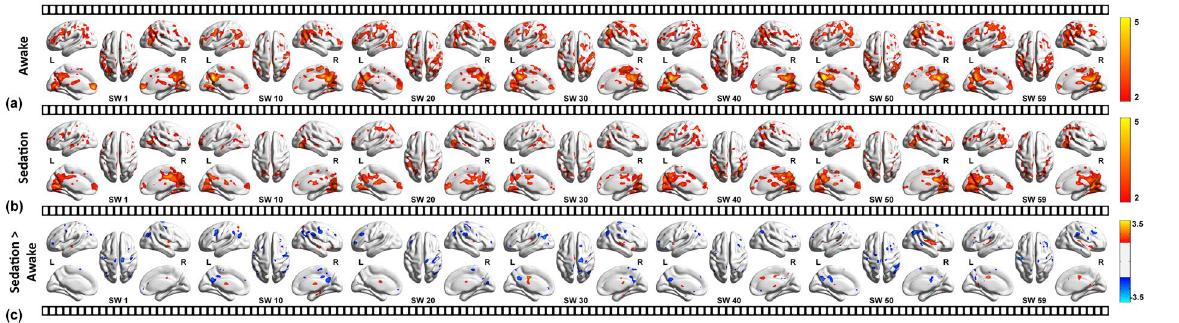
Figure 1. Dynamic functional connectivity during the awake state, sedation and the differences between two conditions is depicted in rows. Seven representative snap shots of integrated local correlation at sliding window 1, 10, 20, 30, 40, 50 and 59 is shown overlapped on BrainNet viewer images. Decreased cortical connectivity is represented in blue and increased deep nuclear connectivity is depicted in red in the last row which represents the effects of